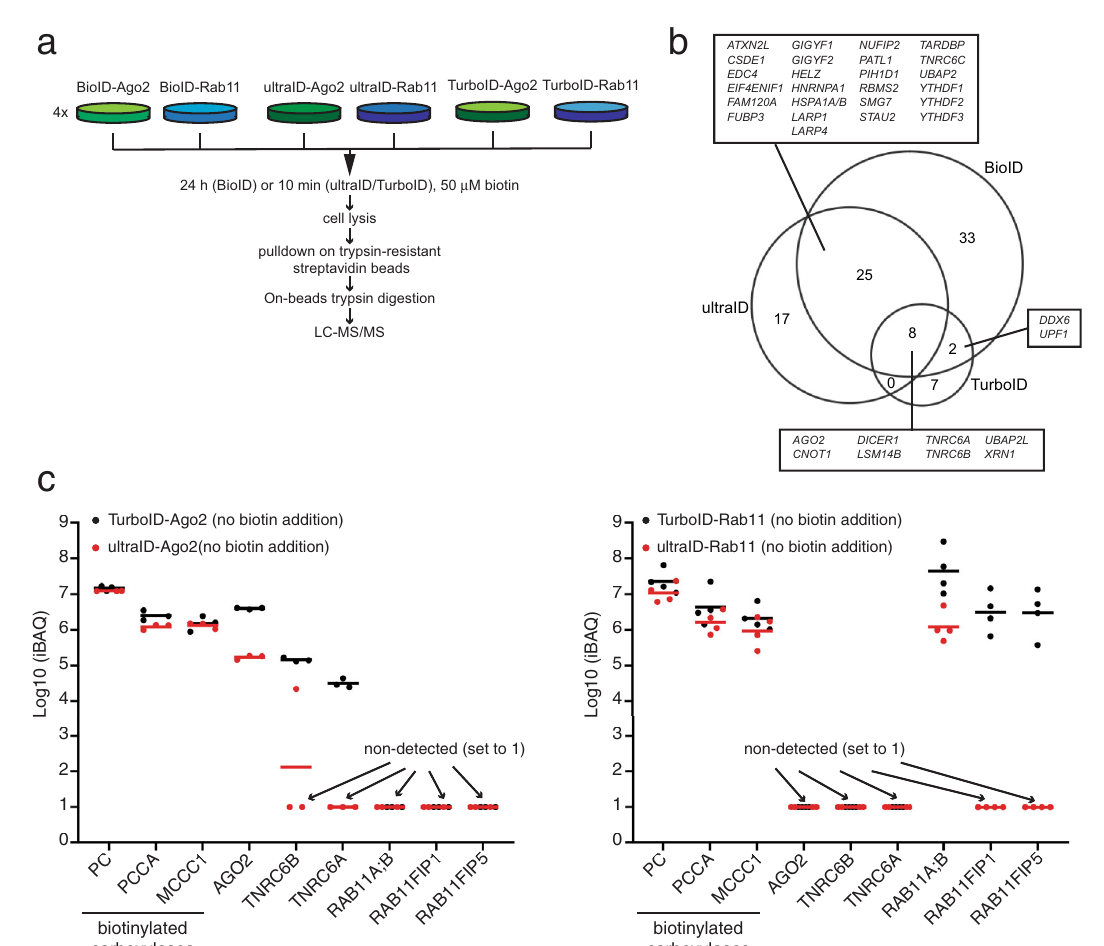
Fig. 7 Ten-min labeling with ultraID under experimental PDB conditions. a Experimental set-up for the side-by-side comparison of overnight labeling with BioID vs. 10 min labeling with ultraID or TurboID. b Venn diagram displaying the proteomic dataset sizes and overlap of the signi fi cant hits from a , the gene names of the dataset overlap are speci fi ed. c Relative abundance, assessed with iBAQ values, of endogenous biotinylated carboxylases and main interacting partners of AGO2 (TNRC6A & B) and RAB11A (RAB11FIP1 & 5), obtained from HeLa cells expressing TurboID-Ago2 and ultraID-Ago2 (left) or TurboID- Rab11and ultraID-Rab11 (right) after streptavidin pulldowns with no biotin addition. Bars are mean values, n = 3 (Ago2 cell lines) or 4 (Rab11 cell